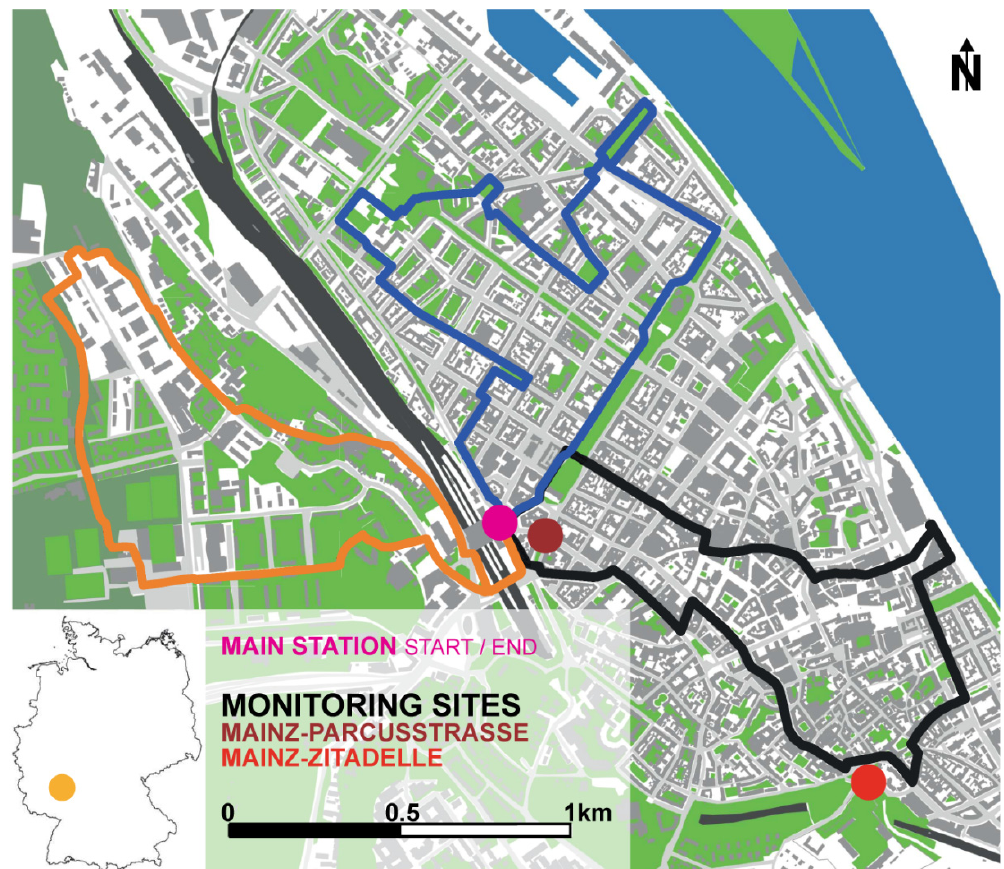
Figure 1. Study tracks in the Mainz Altstadt, Hartenberg, and Neustadt (black, orange, and blue lines, respectively), their joint start and end point at the main station (magenta), and the monitoring sites of the ZIMEN network at Mainz-Parcusstraße (dark red) and Mainz-Zitadelle (red) of the ZIMEN network, and map of Germany showing the location of Mainz (orange).